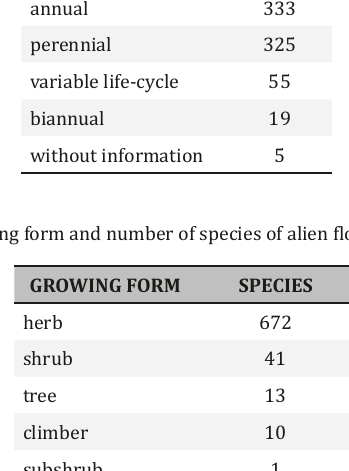
Origin and number of species of alien flora in Chile. ORIGIN